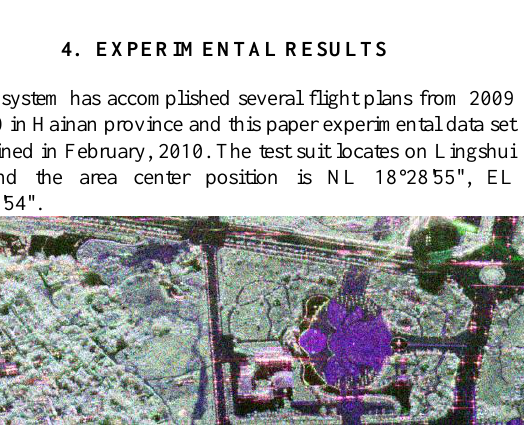
Figure 1. RGB image in pauli basis about Chinese airborne X- band polarimetric SAR after calibration. The top row is the nearest range, and the bottom row is the farthest range.